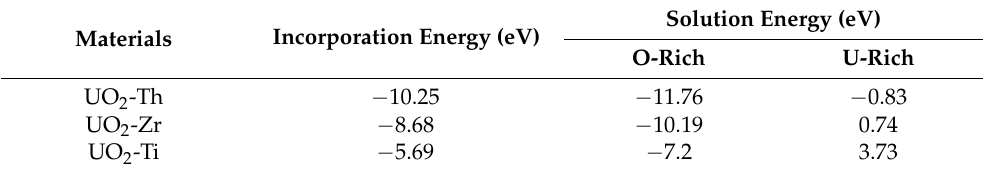
Table 2. Energy properties obtained by substituting U atoms with dopants Th, Zr, and Ti in 2 × 2 × 2 supercells of UO 2 .